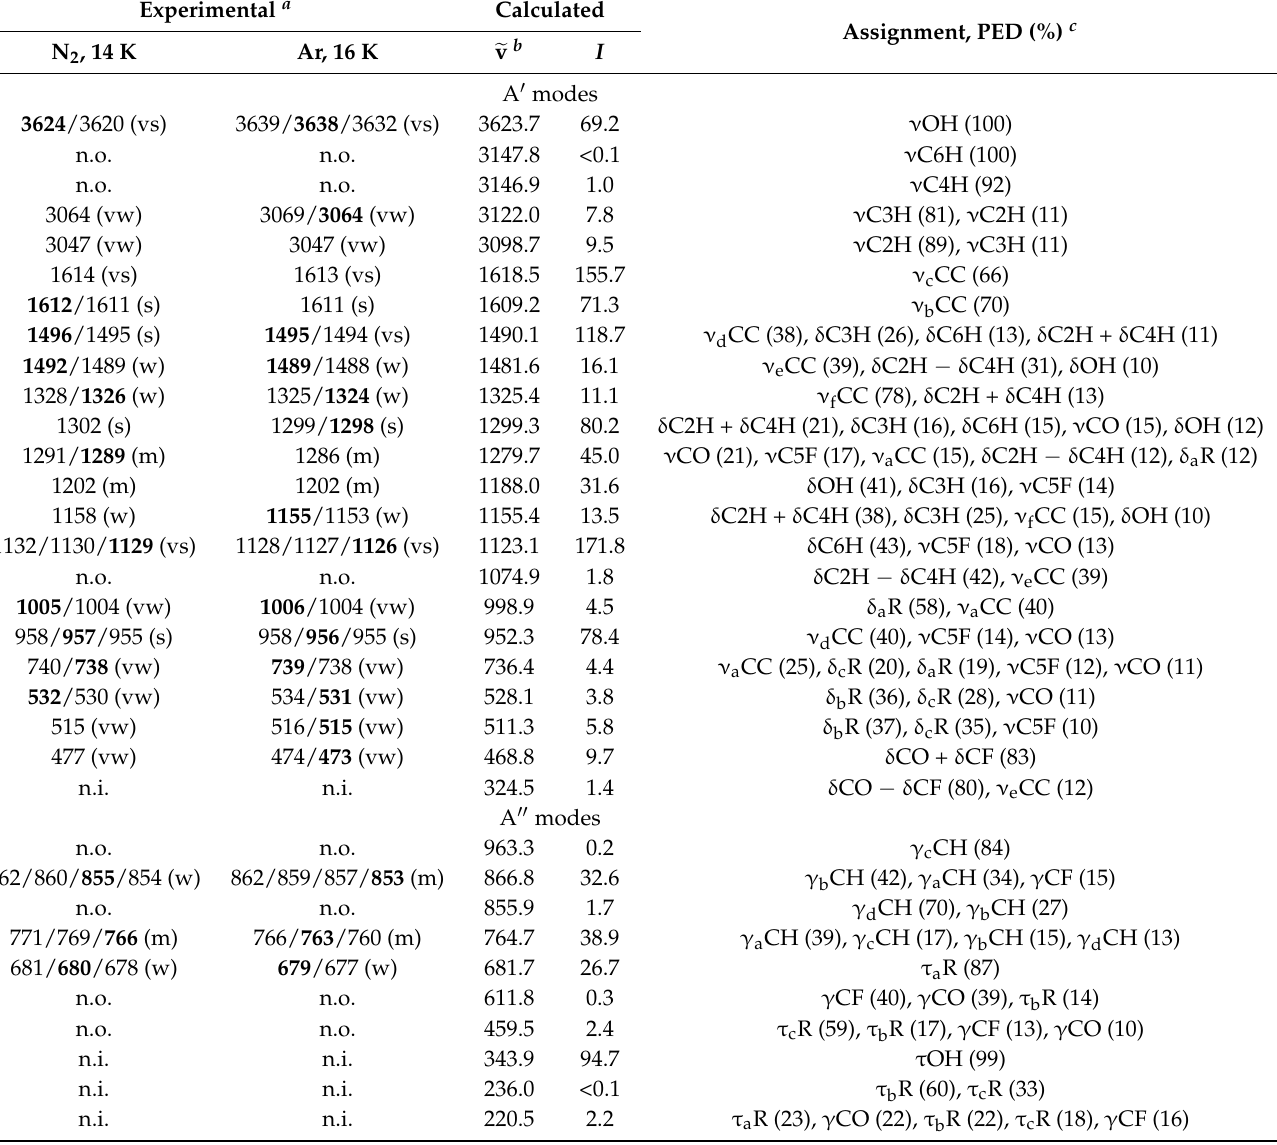
Table 2. Bands observed in the IR spectrum of m FP isolated in nitrogen (N 2 ) and argon (Ar) matrices, compared with the harmonic wavenumbers ( (cid:101) v/cm − 1 ), absolute intensities ( I /km mol − 1 ), and poten- tial energy distribution (PED, %) calculated for the trans conformer of m FP at the B3LYP/aug-cc-pVTZ level of